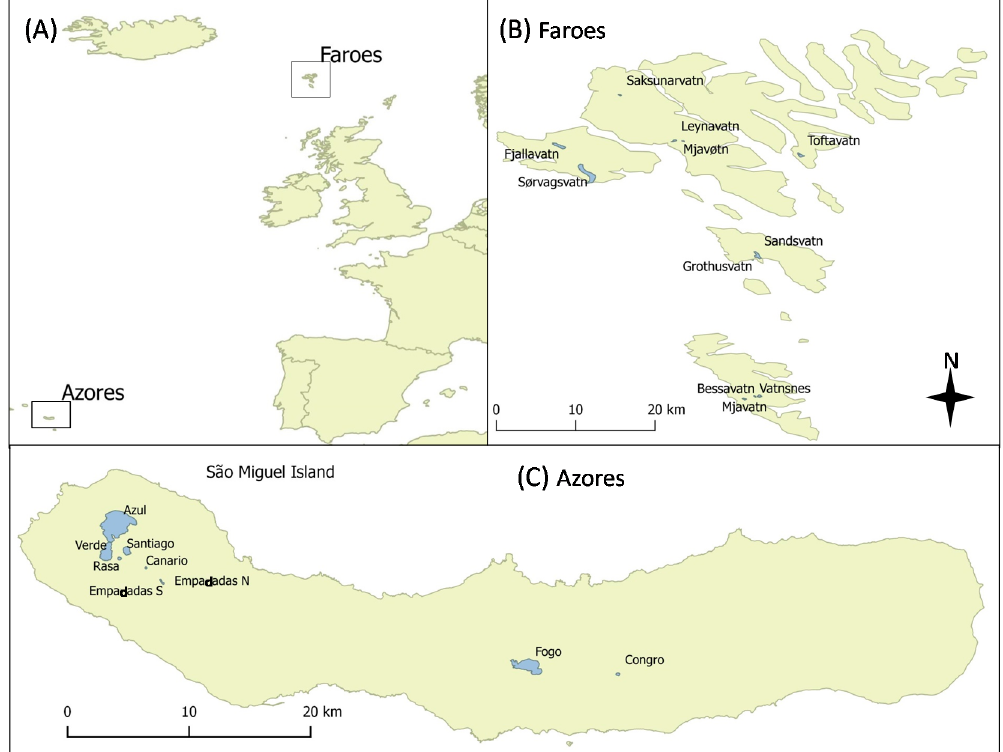
Figure 2. Location of the two groups of island ( A ), showing the studied lakes in the Faroe Islands ( B ) and the Azores, São Miguel Island ( C ).